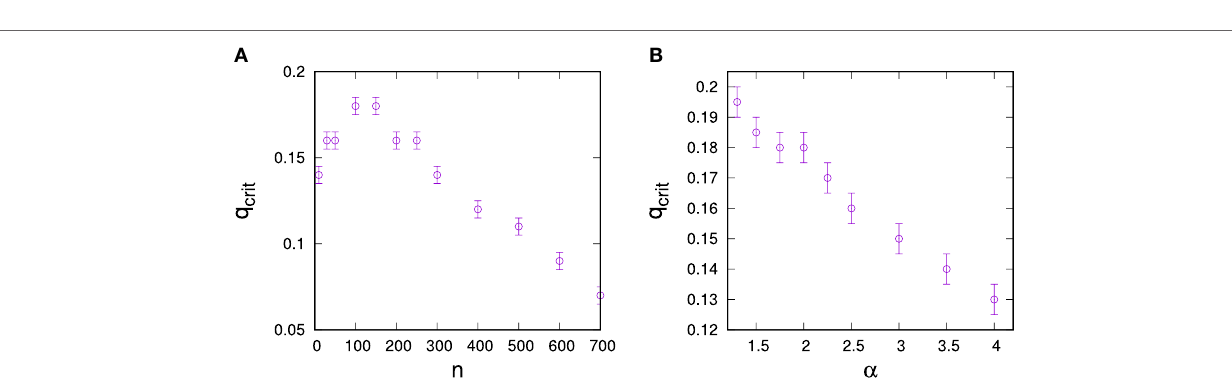
Frontiers in Robotics and AI |